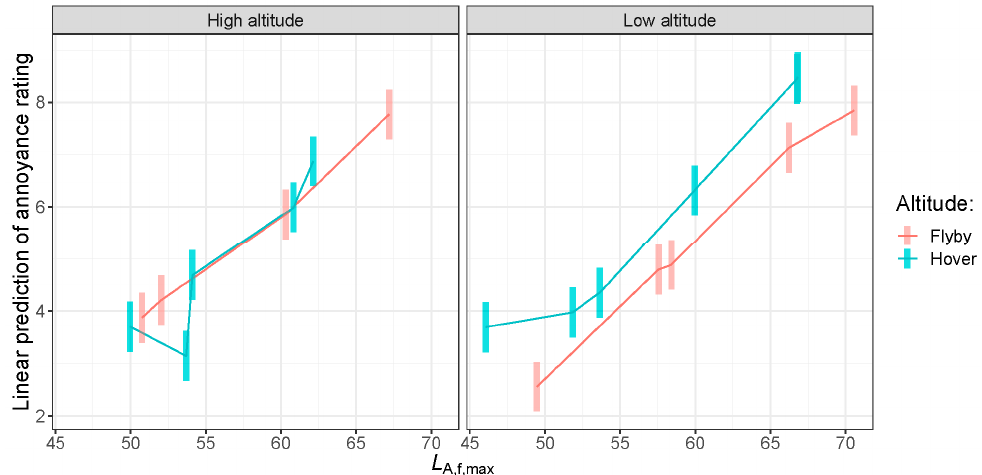
Figure 13. Linear prediction of the annoyance rating from the linear mixed model analysis using L A,f,max as a predictor.